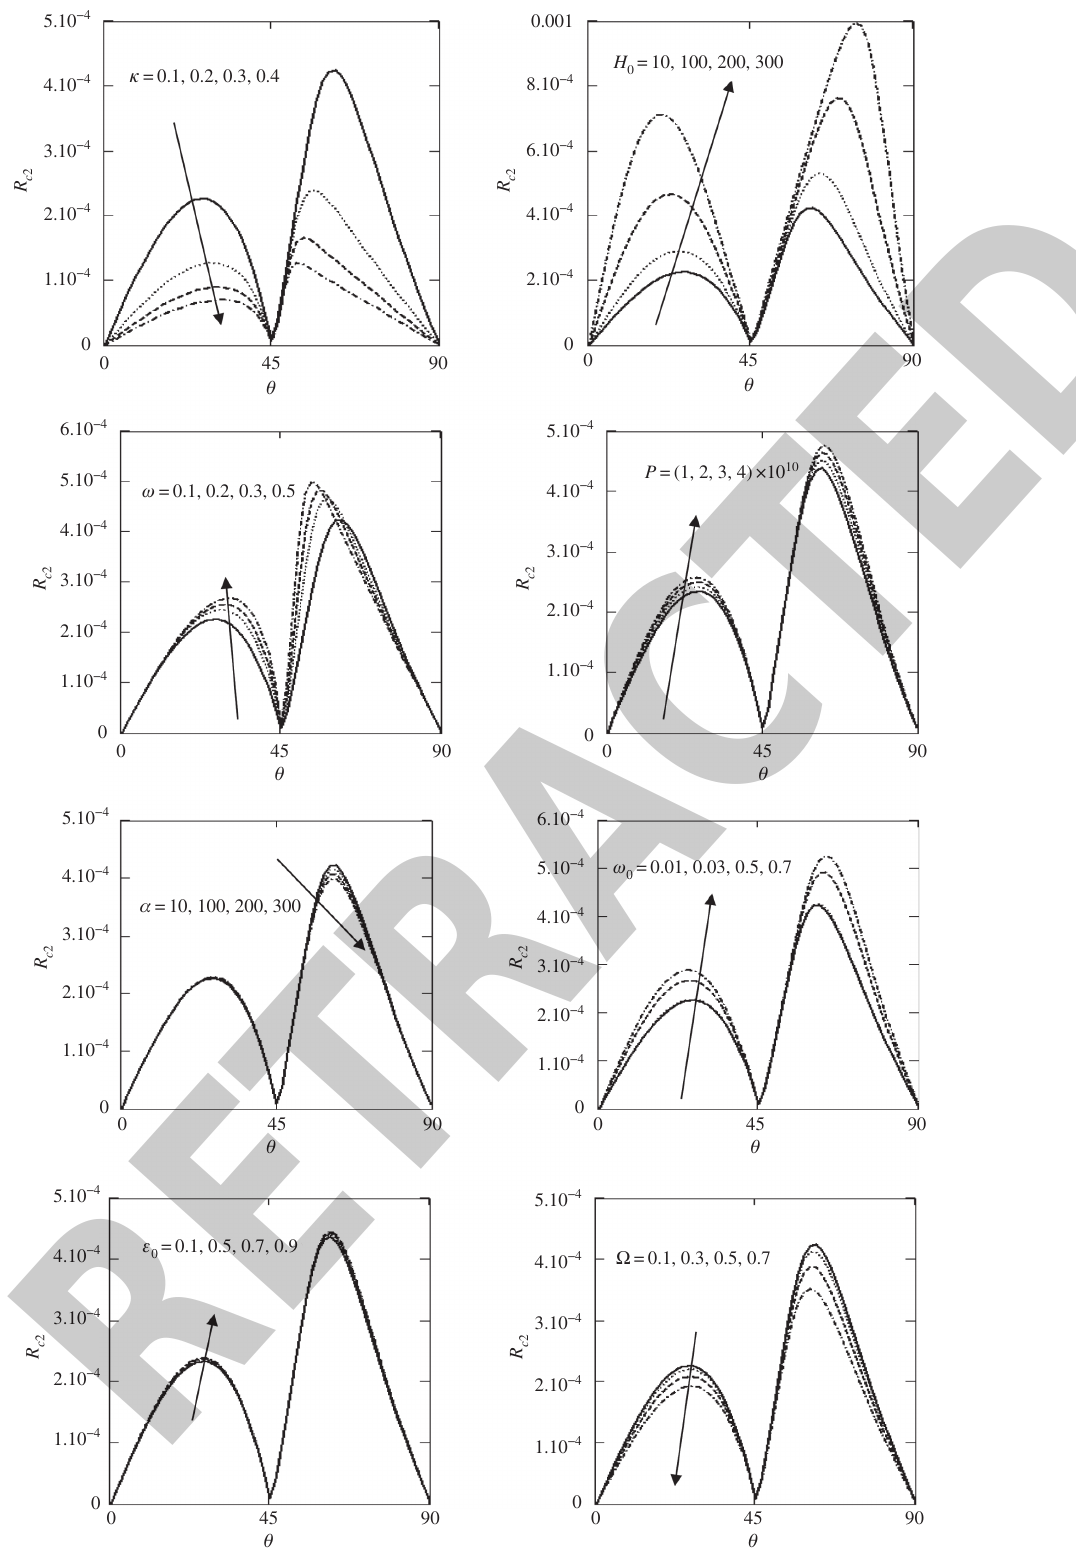
of the compressional (P) wave with variation of κ , H c2